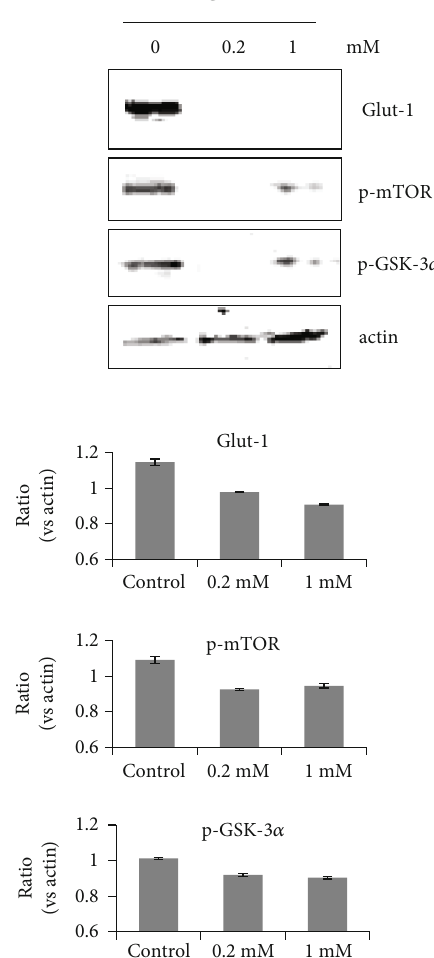
Figure 4: E ff ects of BCAA on the protein levels of Glut-1 and activation of GSK-3 β and mTOR. Western blot analysis of Glut-1 (60 kDa), (46 kDa), and mTOR (289kDa) from extracted astrocytes, following 24 h treatment with 0.2mM BCAA. β -Actin (43 kDa) was used as a loading control. The blots were cropped after stripping (Re-blot plus mild solution, Thermo Fisher Scienti fi c Inc., Goteborg, Sweden) and restaining the same membrane. The protein bands from Western blot fi lms were quanti fi ed with ImageJ (NIH, USA). Control: no treatment. n = 3